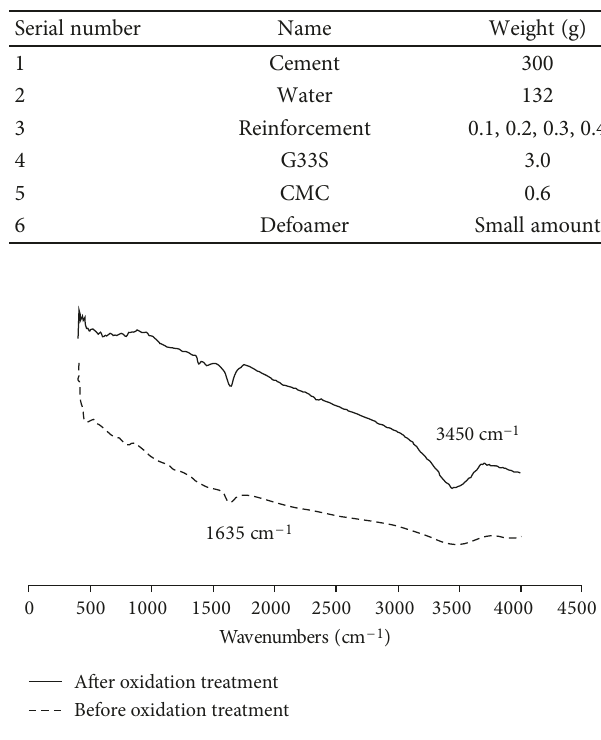
Table 2: Mineral composition of class G oil well cement.